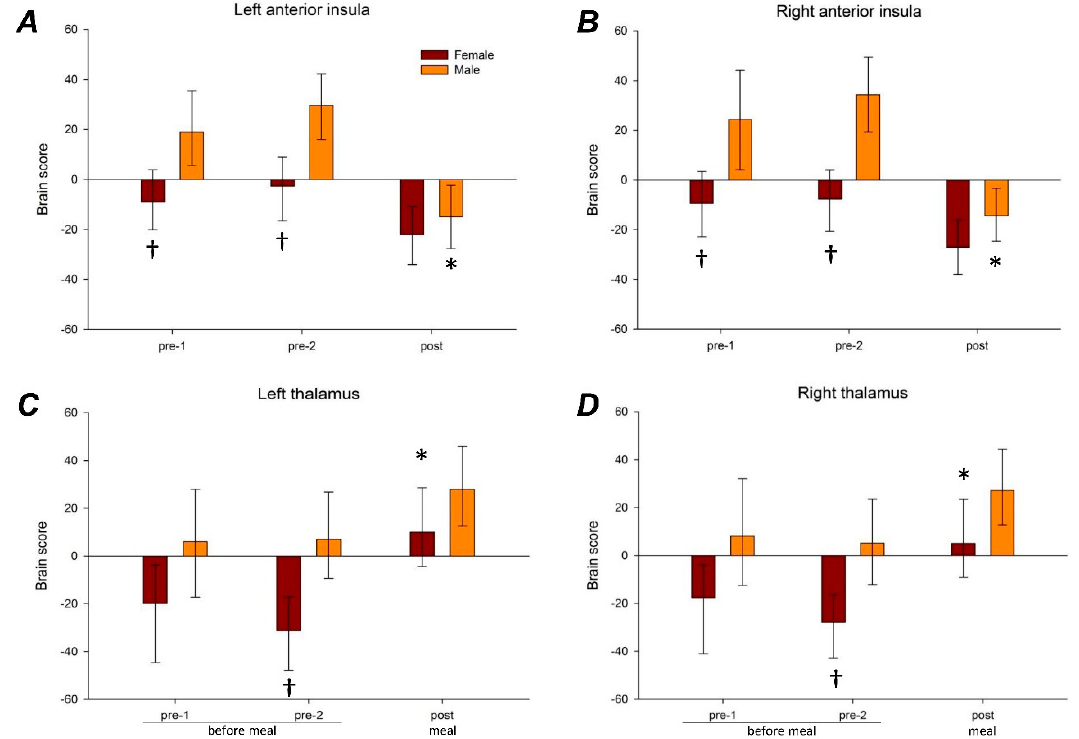
Figure 2. Brain responses to meal ingestion. Brain connectivity summary scores (mean and confidence interval) in the two sequential scans before the meal (pre-1 and pre-2) and in the scan after the meal (post) are plotted according to sex and condition for each region of interest: ( A ) Left anterior insula; ( B ) right anterior insula; ( C ) left thalamus; and ( D ) right thalamus. The brain connectivity summary scores reflect the weightings (analogous to factor scores in a factor analysis) determined by the partial least squares analysis. The brain regions reliably contributing to these weightings are shown in Figure S1. * p < 0.05 vs. Pre (significant ingestion-related change); † p < 0.05 vs. men (significant sex difference within condition). Table 1. Regions of interest (ROI) connectivity affected by meal ingestion.